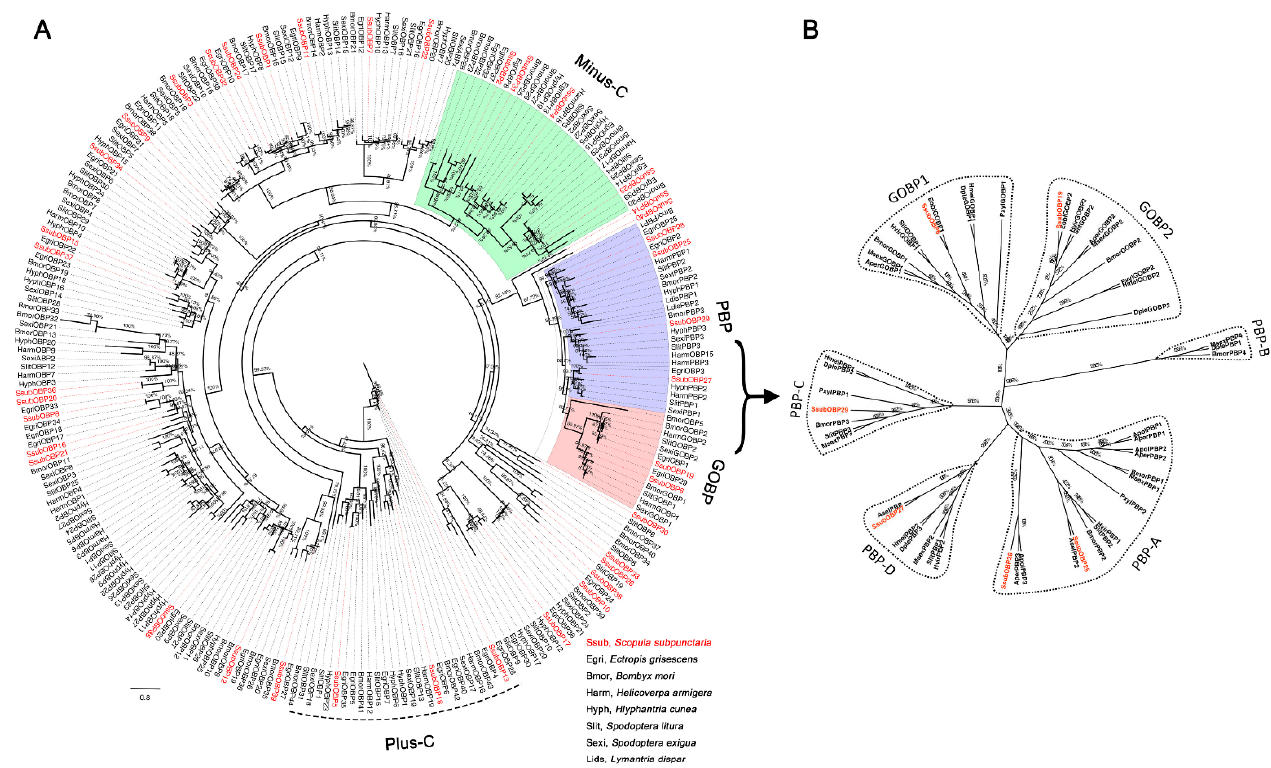
Figure 2. Phylogenetic analysis of SsubOBPs with other lepidopteran insects. ( A ) Phylogenetic analysis of all SsubOBPs with other lepidopteran insects. ( B ) Phylogenetic analysis of candidate SsubPBPs and SsubGOBPs with other lepidopteran insects. The percentages on the branches show the bootstrap values. The group in purple was classified as “PBP”. The group in green was classified as “Minus-C”. The group in red was classified as “GOBP”. The dashed part was classified as “Plus-C”. The phylogenetic tree was constructed in PhyML3.1 using the maximum likelihood method.